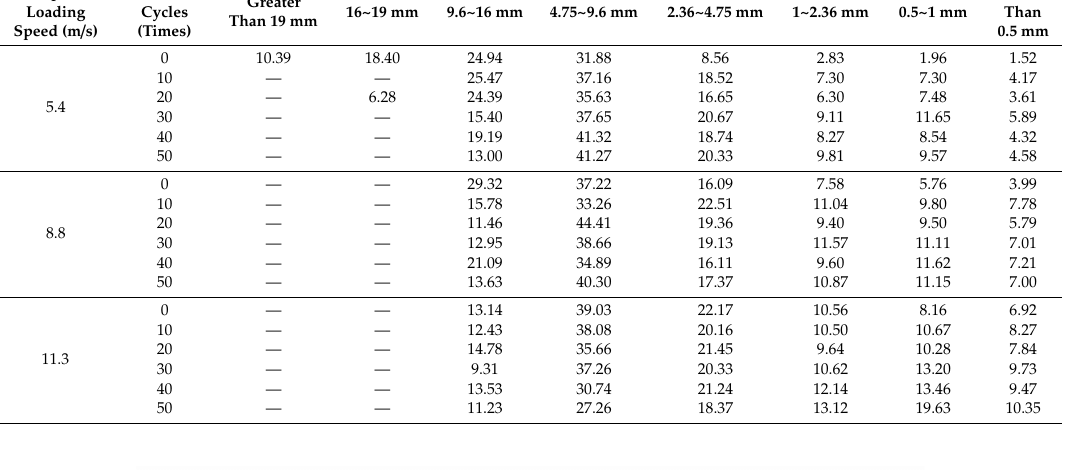
Figure 8. Particle size distribution of crushing blocks under the condition of 0 freeze-thaw cycle with loading speed of 5.4 m/s. ( a ) Greater than 19 mm; ( b ) 16~19 mm; ( c ) 9.6~16 mm; ( d ) 4.75~9.6 mm; ( e ) 2.36~4.75 mm; ( f ) 1~2.36 mm; ( g ) 0.5~1 mm; ( h ) Smaller than 0.5 mm.